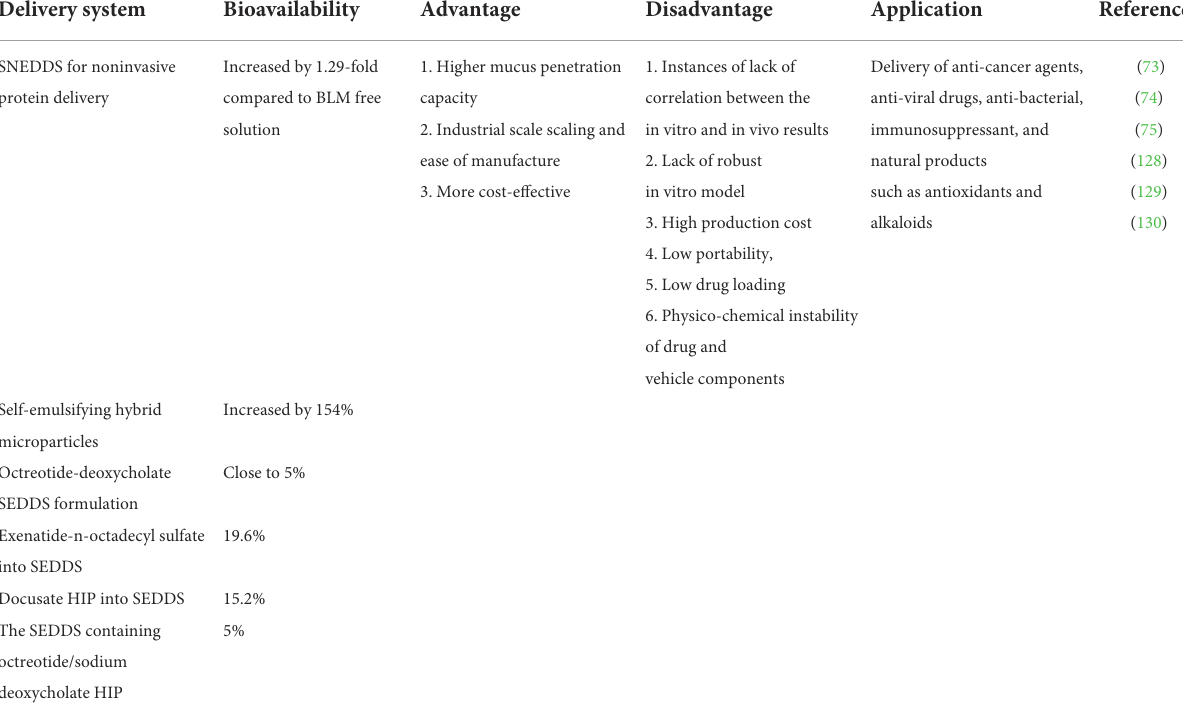
TABLE 3 Application and characterization of self-emulsifying drug delivery